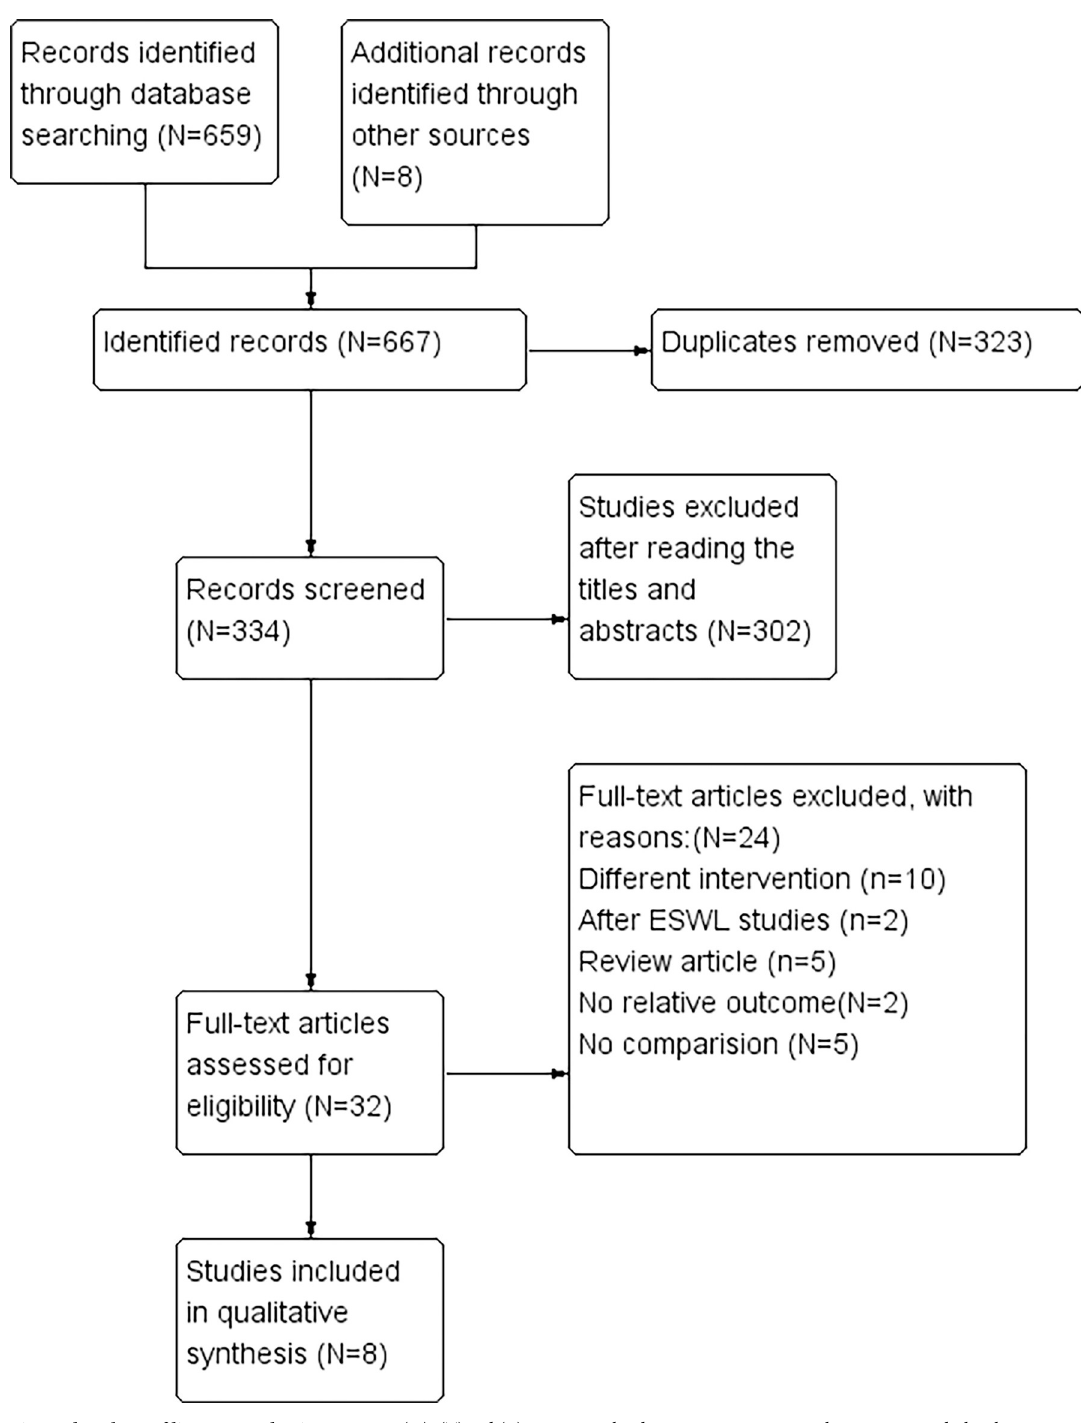
Fig 1. Flowchart of literature selection process. (D), (T)and (P) represent the doxazosin group, tamsulosin group and placebo group, respectively. https://doi.org/10.1371/journal.pone.0245741.g001 (OR = 3.00, 95% CI [2.15, 4.19], I 2 = 0%, P < 0.00001). Expulsion rates of ureteric stones in patients receiving doxazosin ranged from 64% to 81%, while those of the placebo were approx- imately 25% to 63%.